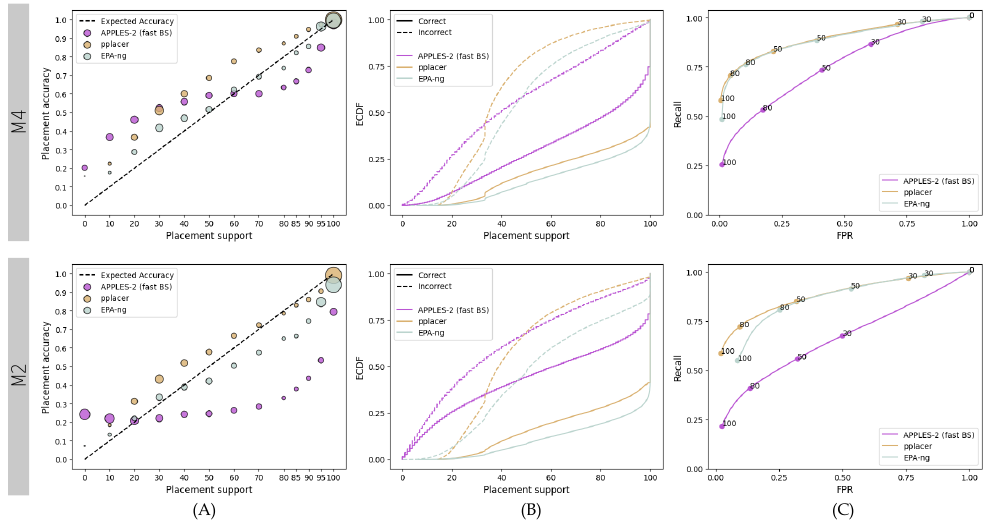
Figure 4. Results for the fragmentary 1000M4 and 1000M2 datasets. We compare support values obtained by pplacer and EPA-ng with the values obtained by APPLES-2 using fast bootstrapping. ( A ) Support vs. Accuracy, ( B ) ECDF, ( C ) ROC